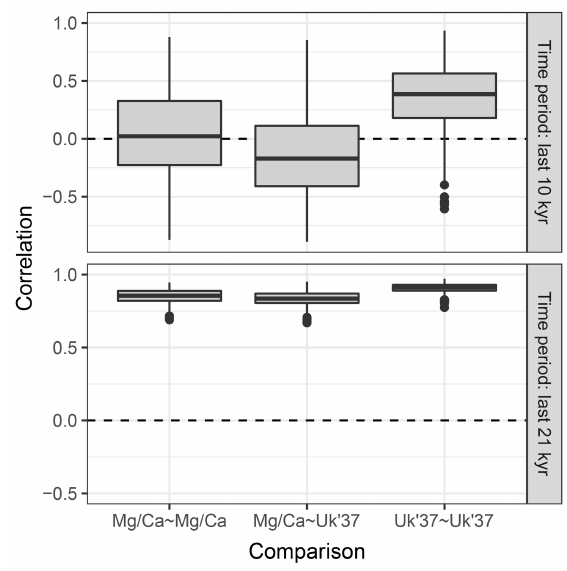
Figure 8. Correlation between replicate pairs of forward modelled proxy